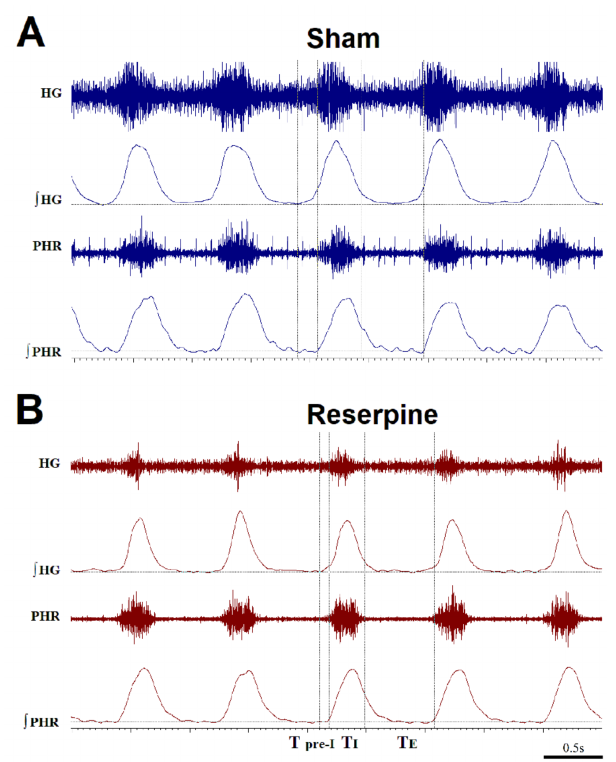
Figure 6. Typical neurogram records of phrenic (PHR) and hypoglossal (HG) nerve activity (raw (cid:82) and integrated signals— ) in sham ( A ) and reserpine ( B ) rats during hypoxia. Note the apparently shortened time of inspiration (T I ) and pre-inspiratory time of HG nerve activity (T pre-I) in the reserpine rats compared to the sham